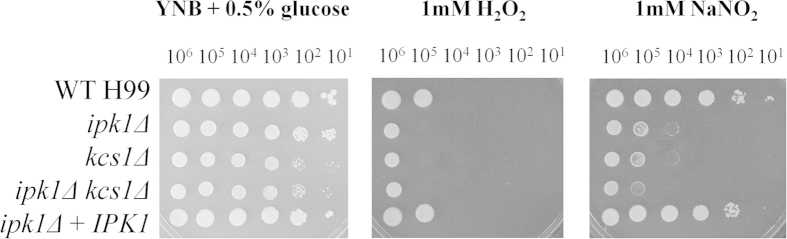
Effect of oxidative and nitrosative stress on growth of ipk1Δ, kcs1Δ and ipk1Δkcs1Δ.All strains were serially diluted 10-fold, from 106 cells to 101 cells per 5μL (left to right) and dropped onto YNB + 0.5% glucose agar containing the reagents indicated. All plates were incubated at 37 °C for 96 hours.